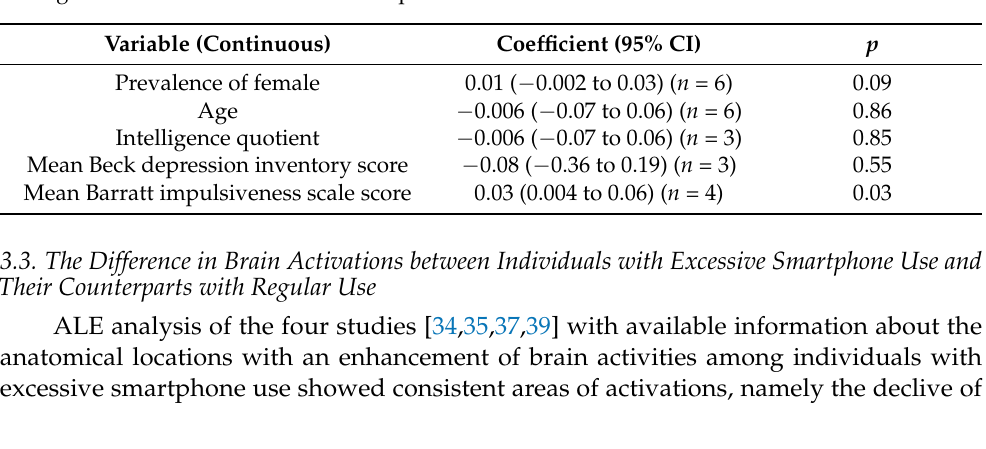
Table 2. Comparison of brain volumes between individuals with excessive smartphone use and Table 3. Regression analysis of correlations between different mediators and changes in brain volume their counterparts with regular use: Hedges’ g. among individuals with excessive smartphone